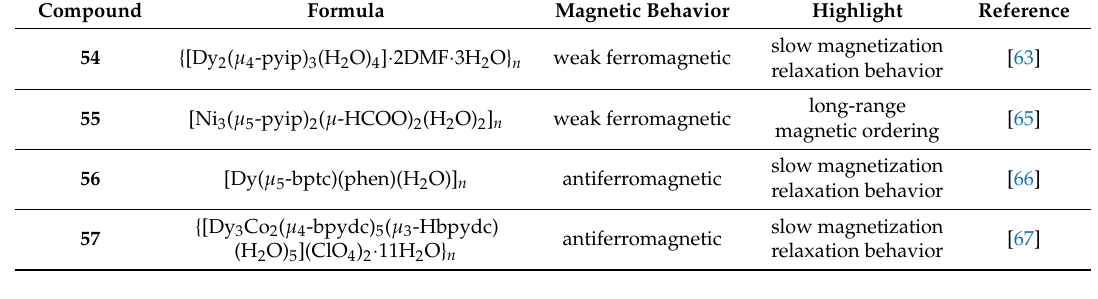
Figure 12. ( a ) 3D metal-organic framework of 54 . ( b , c ) Ac susceptibility of 54 measured in zero dc fields and plotted as χ ′ T vs. T ( b ) and χ ′′ vs. T ( c ). Adapted from [63].